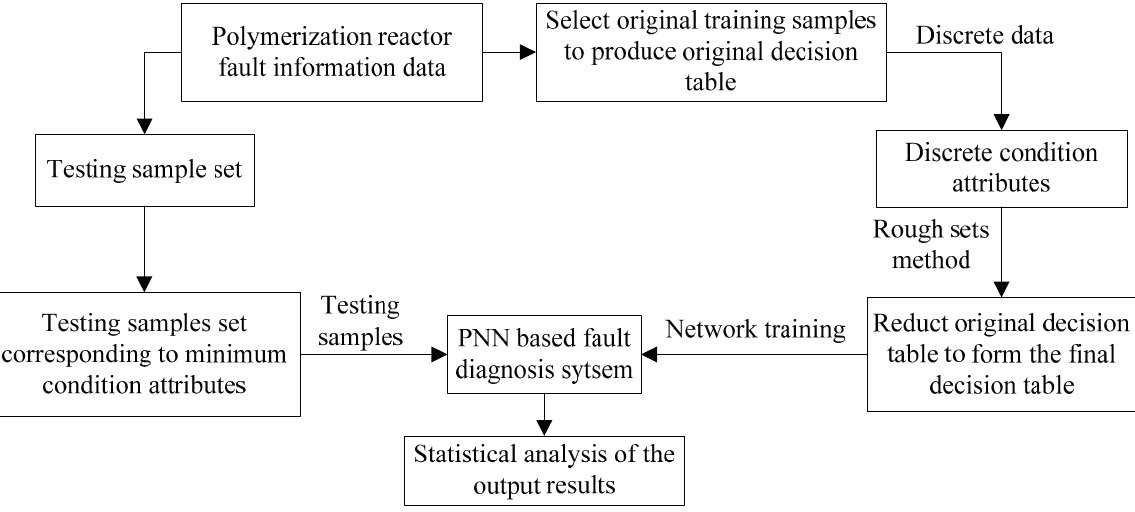
Figure 5. Flowchart of Polymerization fault diagnosis system based on Rough Set and